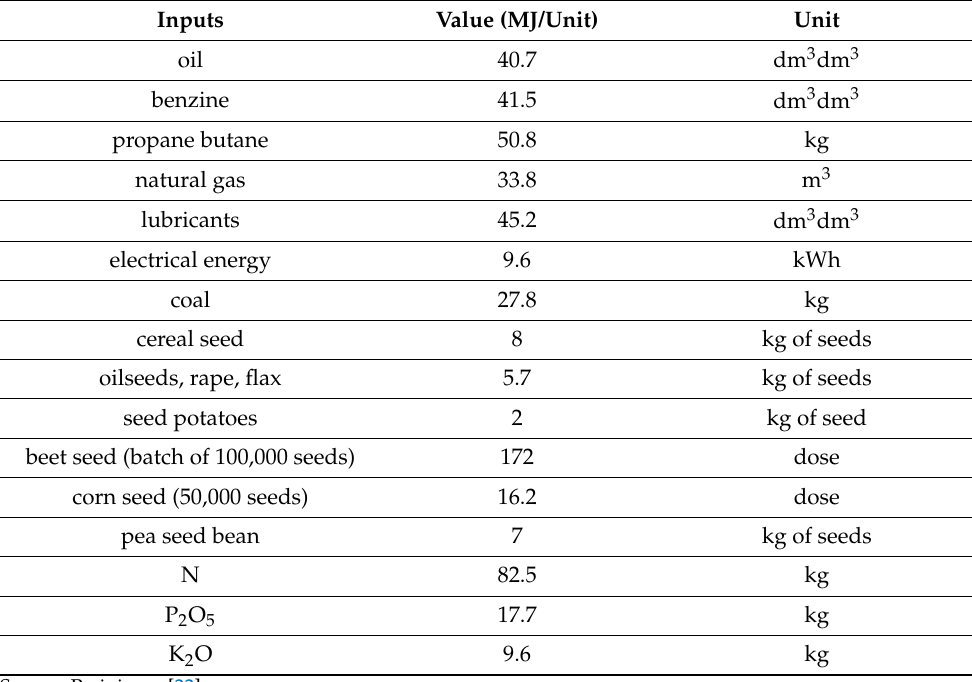
Table A6. Energy of used materials.